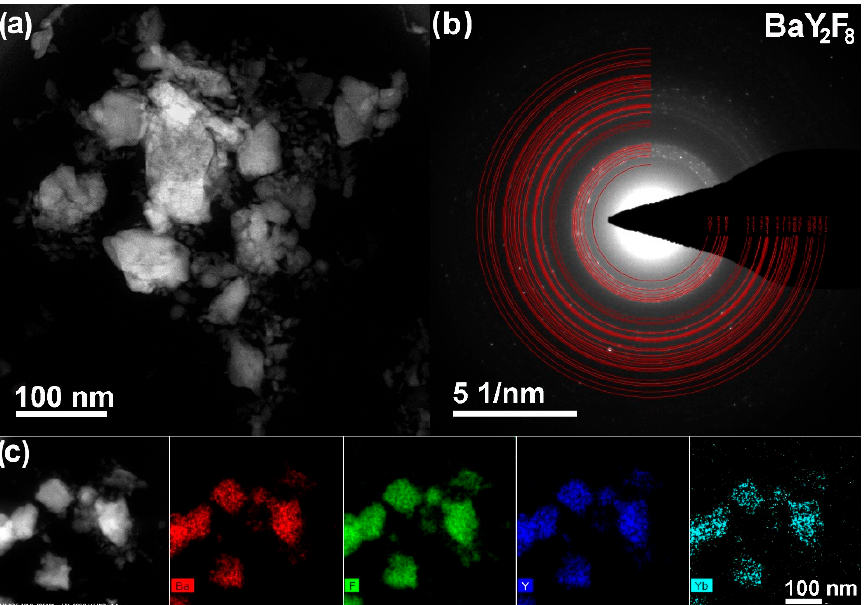
Figure 3. ( a ) HAADF-STEM image of Ba(Y 0.964 Yb 0.030 Er 0.006 ) 2 F 8 NPs; ( b ) the corresponding SAED pattern with the overlaid JEMS simulated rings of the BaY 2 F 8 monoclinic phase (sp. gr. C 2 / m, a = 0.698 nm, b = 1.051 nm, c = 0.4261 nm, β = 99.676°); ( c ) HAADF-STEM image of Ba(Y 0.964 Yb 0.030 Er 0.006 ) 2 F 8 NPs and the corresponding EDX elemental mapping of Ba L-line (red), F K-line (green), Y L-line (blue), and Yb M-line (light blue). HRTEM image of the Ba(Y 0.964 Yb 0.030 Er 0.006 ) 2 F 8 NPs produced by high-energy milling of a bulk crystal and the corresponding diffractograms of nanocrystals A and B are pre- sented in Figure 4. Interpretation of FFT diffractograms using JEMS shows that A and B NPs are oriented along the [311] and [312] directions.